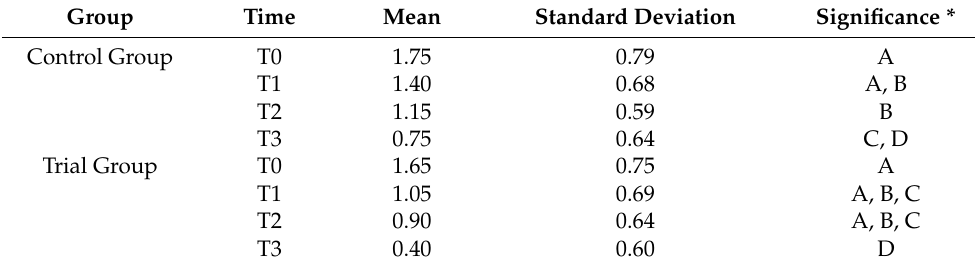
Table 2. Descriptive statistics of BEWE measurements.